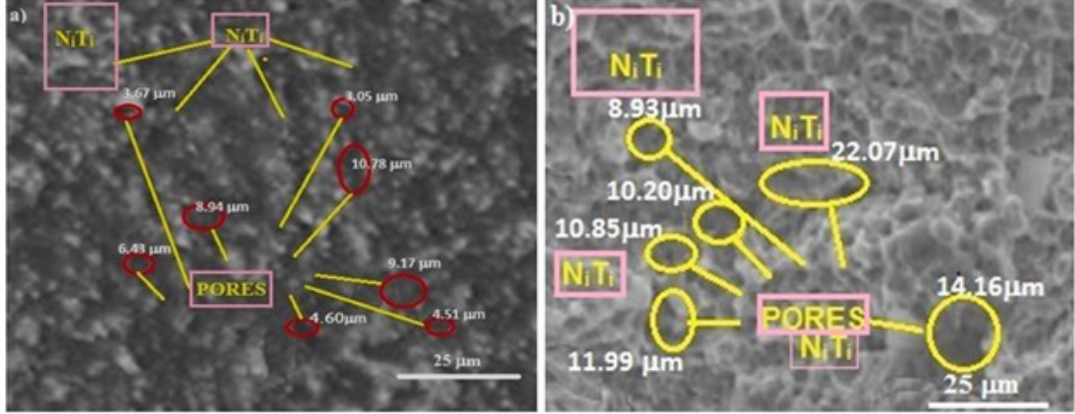
Figure 6. SEM images of Nitinol composite at 1000 0 C temperature with a) sintering time for 5 min b) sintering time for 30 min.